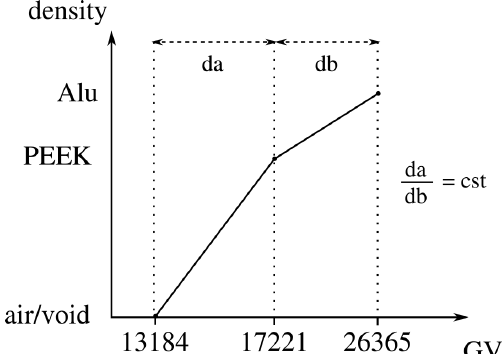
Figure A1. Measured grey values as a function of corresponding density in scan 00.